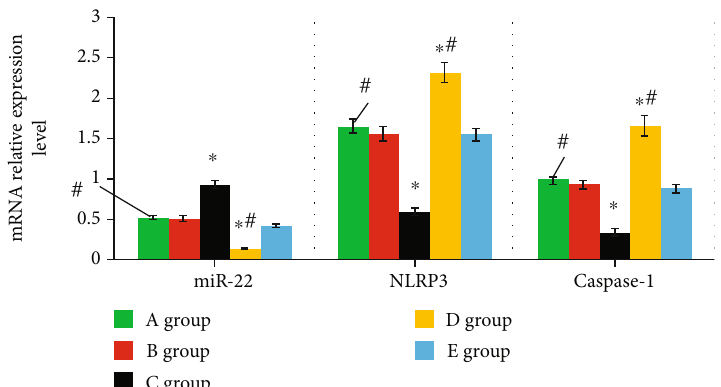
Figure 5: Levels of miR-22, NLRP3, and caspase-1 mRNA. ∗ indicated that the comparison with group A showed P < 0 : 05 . # indicated the comparison with group C showed P < 0 : 05 . Among the above items, group A was the blank group, group B was the negative group, group C was the miR-22 mimics group, group D was the miR-22 inhibitor group, and group E was the miR-22 inhibitor+siNLRP3 group.